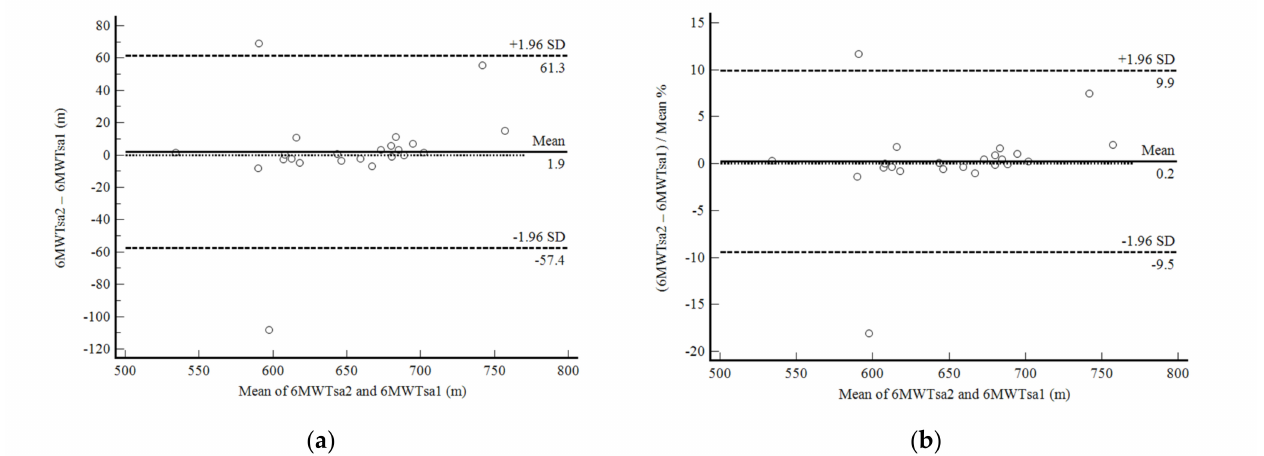
Figure 3. Bland and Altman graphic method with limits of agreement and 95% confidence interval (95%CI) between the distance walked estimated by the number of steps and demographic and anthropometric attributes in the second self-administered six-minute walk test (6MWTsa2) and first (6MWTsa1). ( a ) absolute values; ( b ) percentage values.